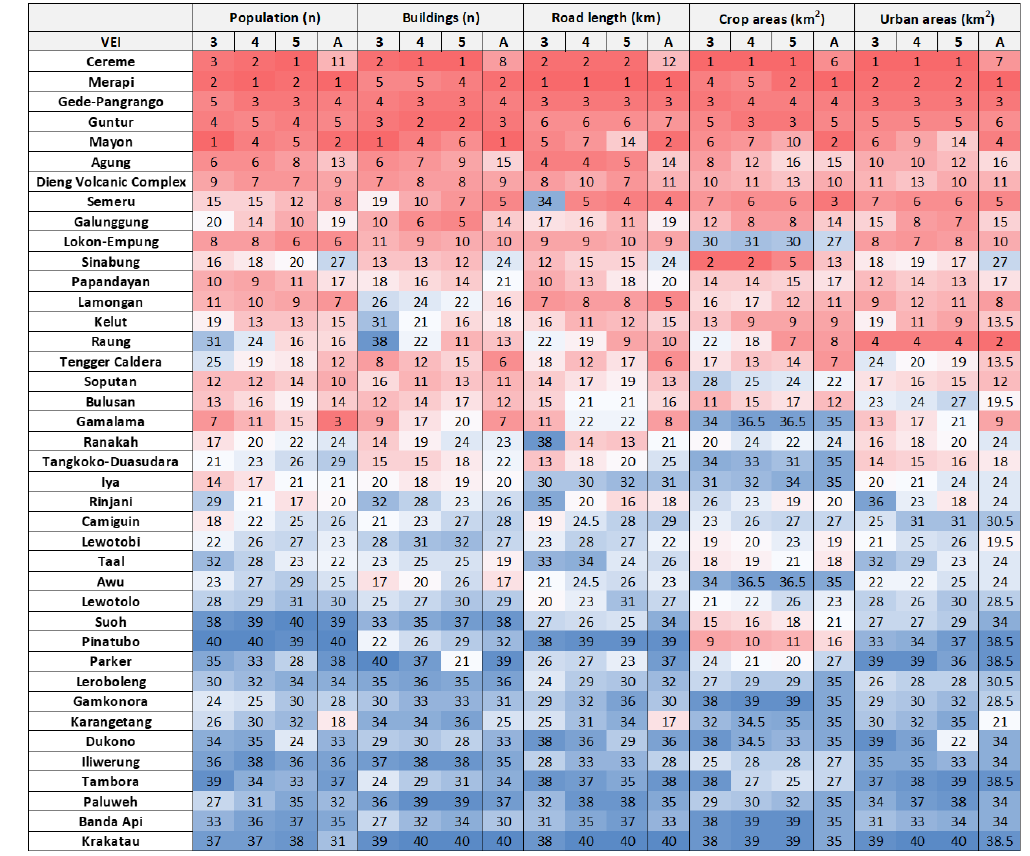
Figure 15. Individual rankings for calculated exposure using the 50% column collapse PDC hazard. Column names, volcano order and cell colour same as for Fig.